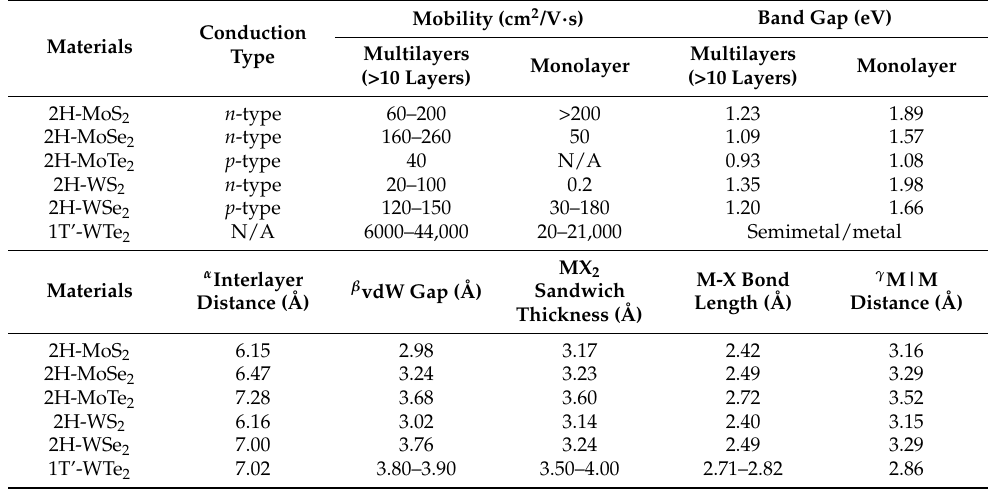
Table 1. Electrical characteristics and structure dimensions of 2D TMD